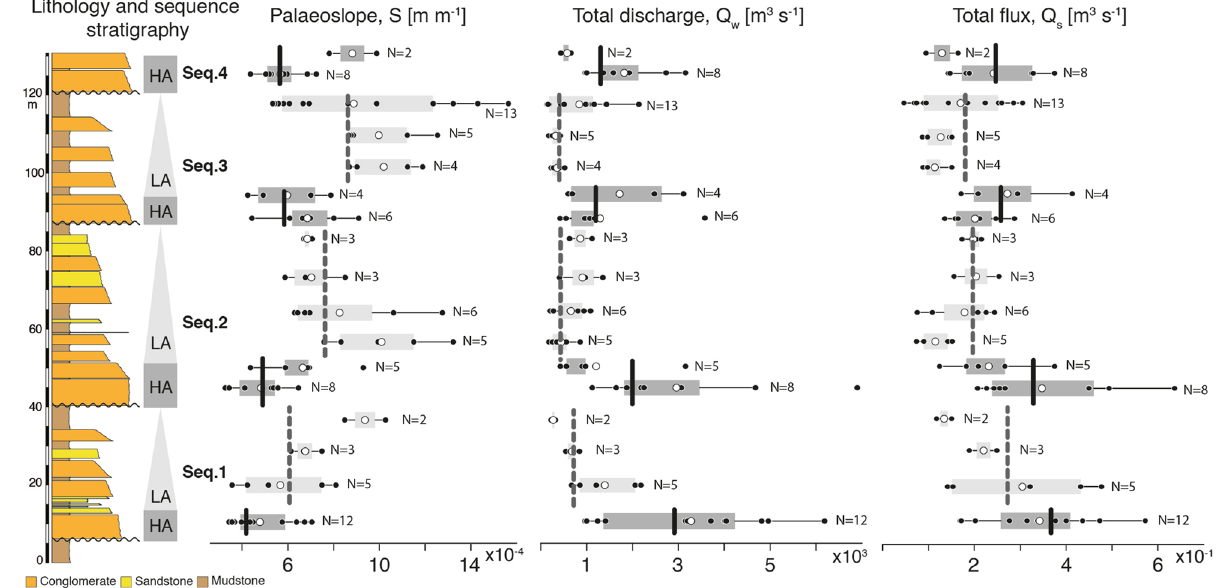
Figure 7. Palaeoslope, total water discharge and total bedload sediment flux estimates. Palaeoslope evolution along with estimates of total water discharge and total bedload sediment flux relative to each sampled storey within the HA and LA intervals of the studied sequences. Black vertical bars denote the average value in HA intervals while grey bars denote the average value in LA intervals. It is important to note the relationship and cyclical pattern, as shown by the overall average values in HA and LA intervals, between the three parameters such that river slope is lower when total discharge and total flux are higher (and conversely). Unit fluxes (water and sediment) have similar patterns of variations and are provided in supplementary figures S5 and